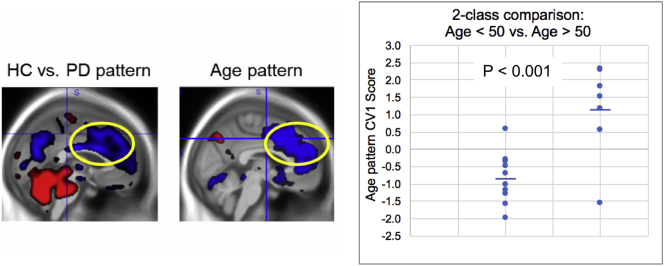
Age-related pattern identified by NPAIRS CVA in the comparison of HC subjects <50 and ≥ 50 years of age (graph and right image). The yellow oval focuses on the overlap between the age pattern (right) and the pattern comparing HC and PD subjects (left), where the PD subjects were somewhat older than HC on average. Results are split-half test results (consensus pattern generated using test results of many iterative data splits). Horizontal bars represent group means.